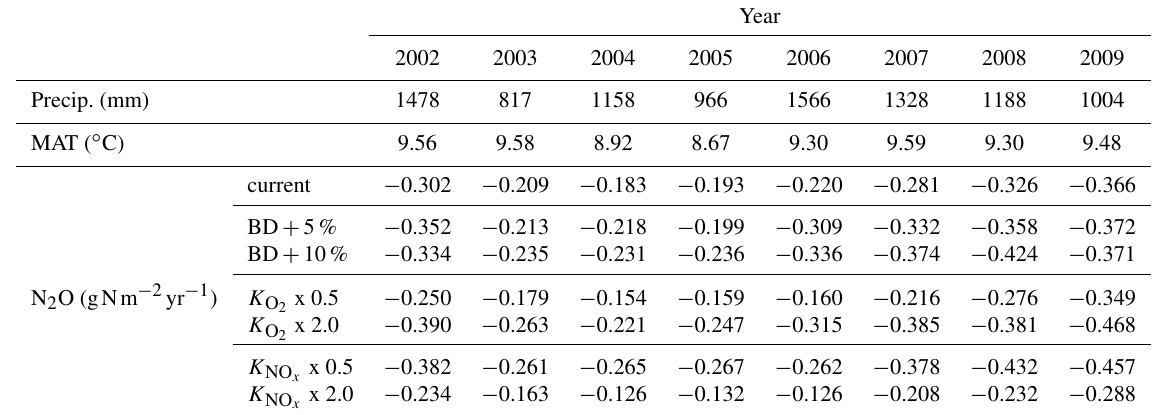
Table 5. Annual N 2 O emissions modelled with current field management (Table 2) and soil properties (Table 1) (current), with soil bulk density (BD) increased by 5 and 10% to a depth of 3cm, and with the Michaelis–Menten constants for reduction of O 2 ( K O ) halved or doubled from those used in the and NO − ( K NO 2 x